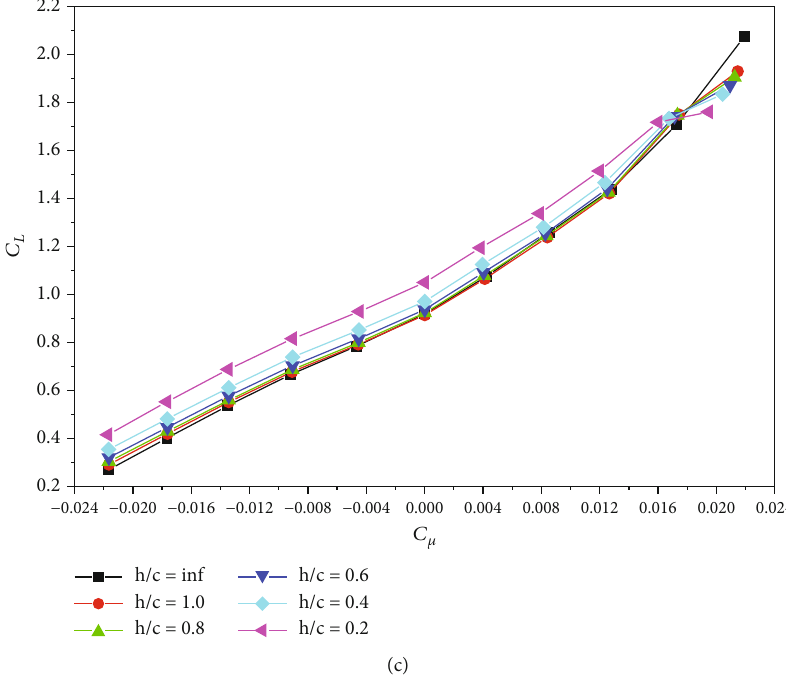
Figure 8: Curves of lift coe ffi cient at various ride heights: (a) α = 0 ° ; (b) α = 4 ° ; (c) α = 8 ° .